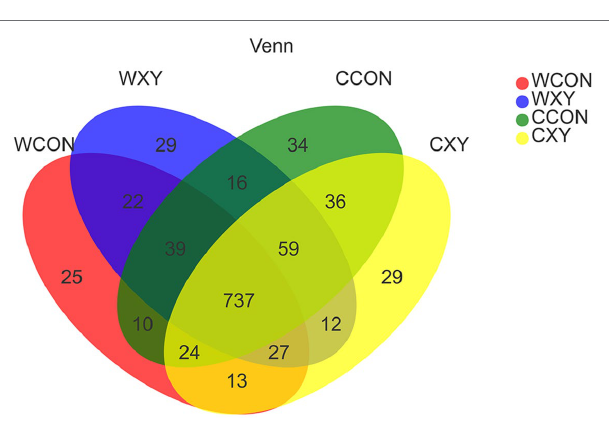
FIGURE 3 | Bacterial OTU community composition of the broilers fed corn- or wheat-based diets. Venn diagrams were generated to make qualitative comparisons of the core and unique OTUs among WCON, WXY, CCON, and CXY groups. OTUs, operational taxonomic units. Wheat-soybean basal diet (WCON); wheat-soybean basal diet with 4,000 U/kg xylanase (WXY); corn-soybean basal diet (CCON); and corn-soybean basal diet with 4,000 U/kg xylanase